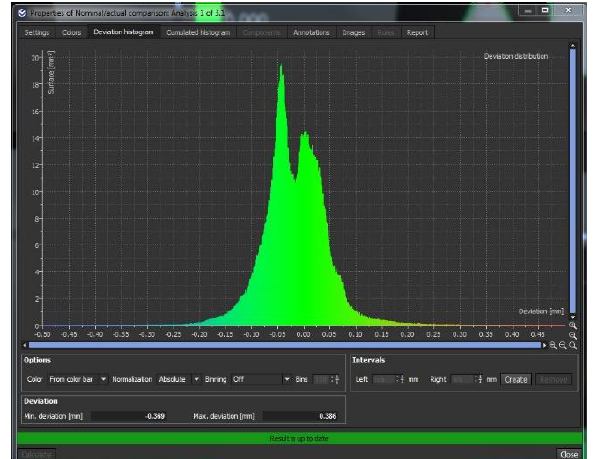
Figure 13. Volumetric deviation from CAD model on test plate No. 3.1. A bimodal distribution can be seen, suggesting that a systematic error source was present during manufacturing.